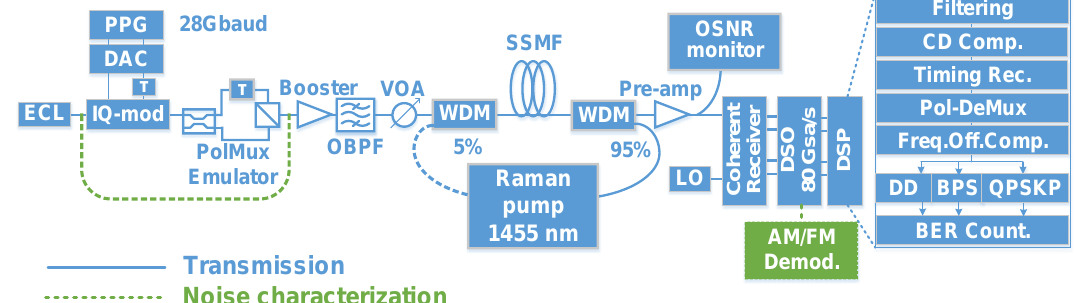
Figure 1. Experimental setup of distributed Raman amplified coherent transmission link. PPG: pulse pattern generator; DAC: digital-to-analog converter; WDM: wavelength division